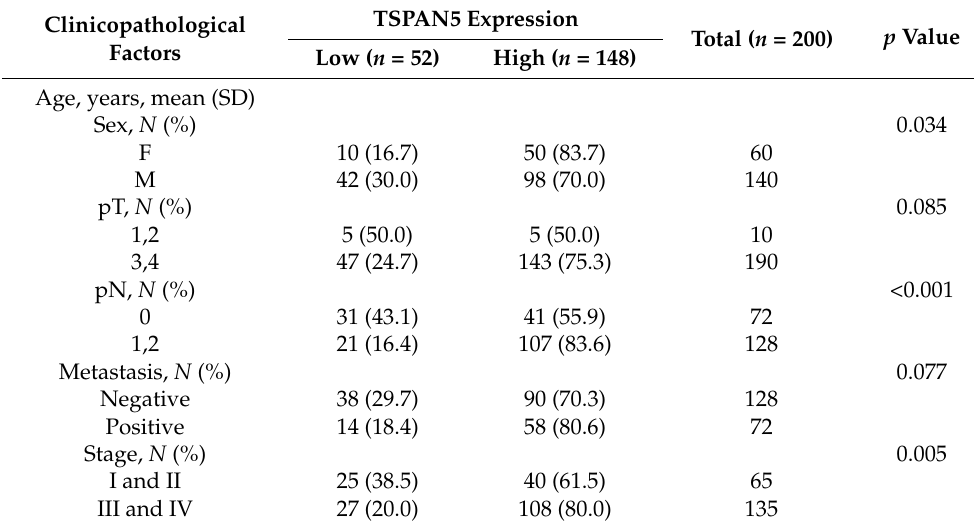
Table 1. Relationship between chi-square values for TSPAN5 expression and the clinicopathological factors of colorectal cancer.